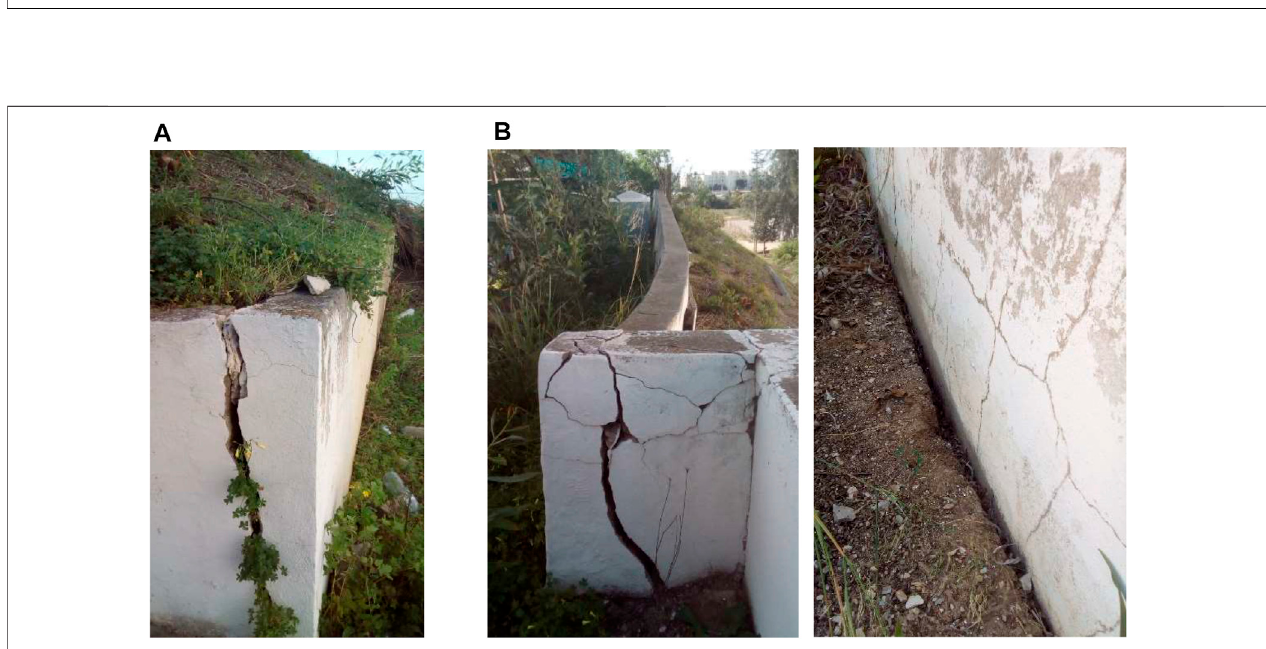
FIGURE 3 | Damages in retaining walls at the National Engineering School of Tunis (Manigniavy, 2021). (A) . reinforced concrete wall subjected to active pressures induced by expansive clays. (B) . Unreinforced concrete wall subjected to active pressures induced by expansive clays.